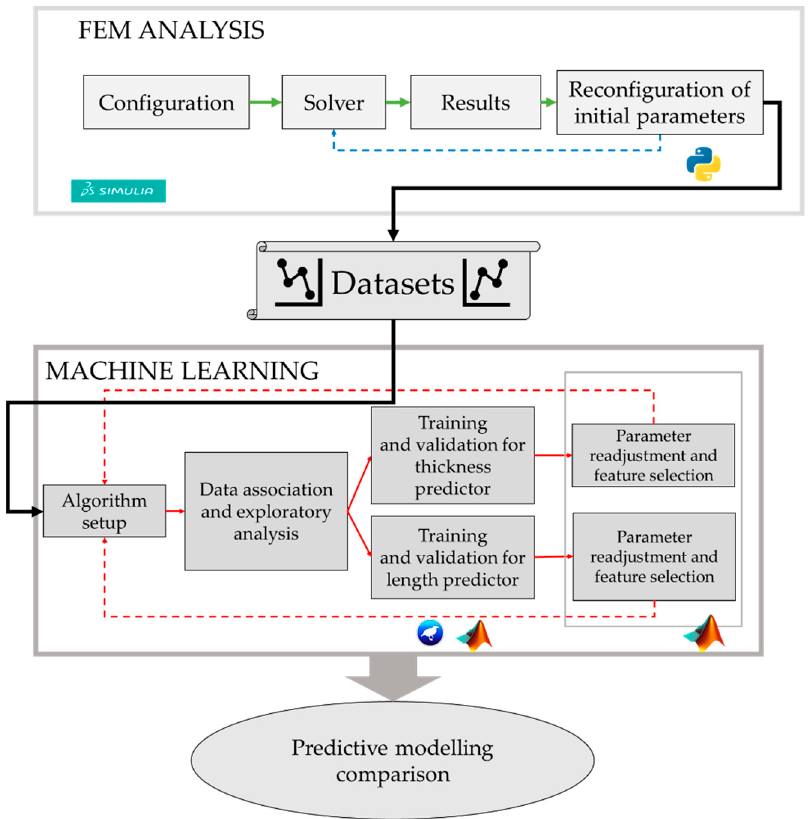
Figure 1. Workflow for the hybrid methodology applied.